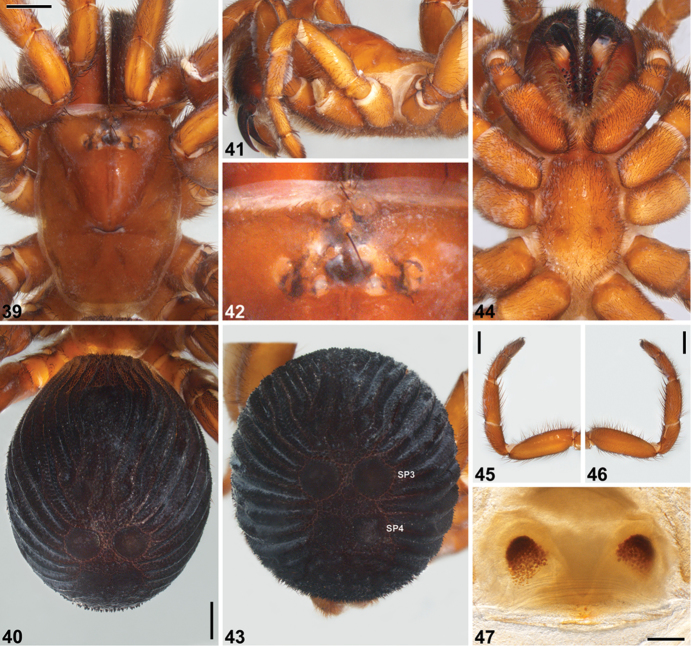

Idiosoma
nigrum Main, 1952, female holotype (WAM T3960) from Wongan Hills (Western Australia; AVW). 39–40 Carapace and abdomen, dorsal view 41 Carapace, lateral view 42 Eyes, dorsal view 43 Abdomen, posterior view 44 Sternum, ventral view 45 Leg I, prolateral view 46 Leg I, retrolateral view 47 Spermathecae, dorsal view. Scale bars 2.0 (39–40, 45–46), 0.5 (47). SP3–4 = sigilla pairs 3–4.